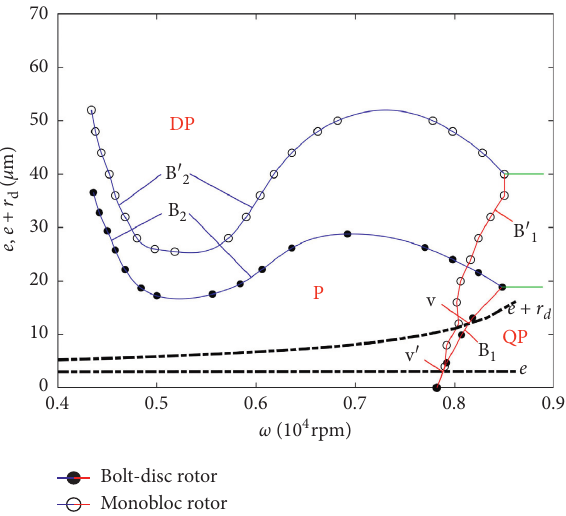
Figure 6: Global stability boundaries and